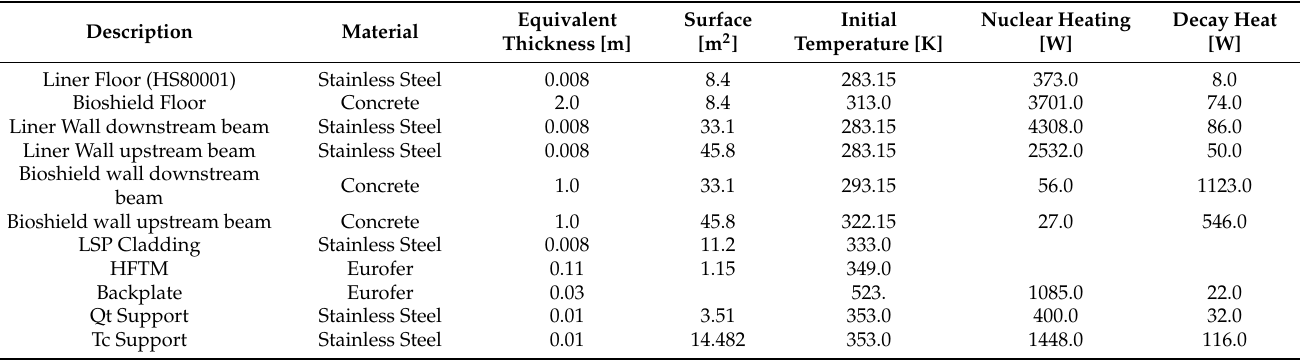
Table 2. Heat structures within the Test